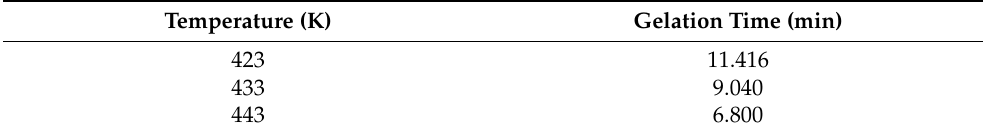
Figure 12. The fitting line for the gelation time of the H 6 XDI/BES system. The parameters of the gelation model were calculated based on linear fitting. The slope of the fitting line gave E (cid:2917)(cid:2915)(cid:2922) = 39.951 kJ/mol and the intercept gave B= −8.917 . These parameters were put into Equation (18), giving the equation correlating the gelation time t (cid:2917)(cid:2915)(cid:2922) with the temperature: